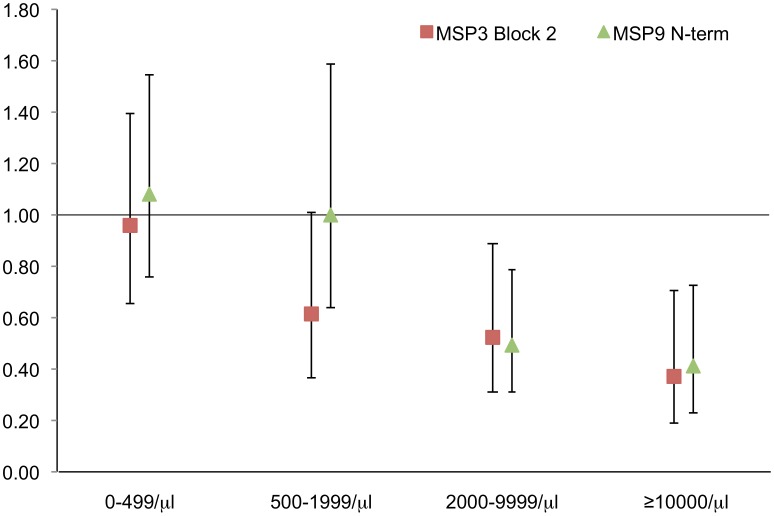
Association between antibodies to PvMSP3α(Block II) and PvMSP9(N-terminal) proteins and risk of P. vivax malaria.Data are plotted as exposure and age adjusted incidence rate ratios (aIRR(exp)) ± 95% confidence intervals for febrile episodes with different levels of concurrent P. vivax parasitaemia.